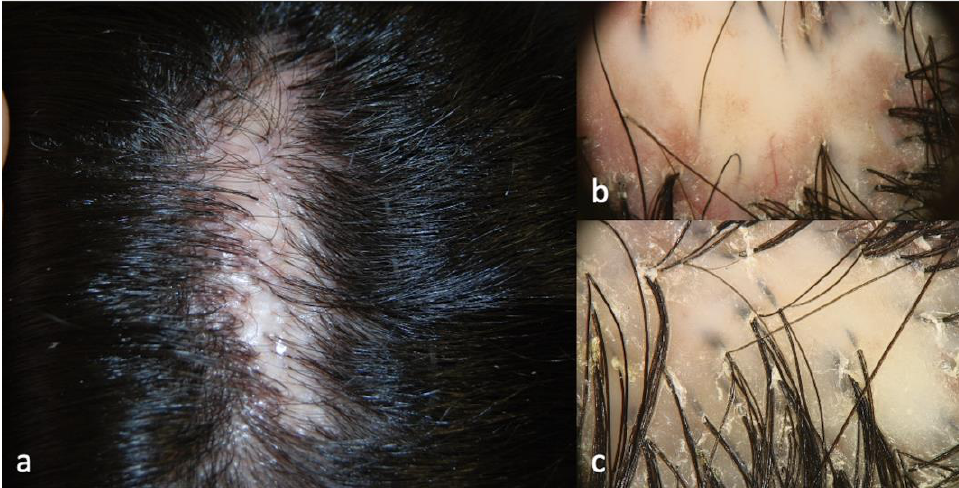
Figure 2. Histological findings of Patient 1. ( a ) Parakeratosis, focal absence of granular layer, neu- trophilic infiltrate in the papillary dermis and mantles (sebaceous structures), H&E 10× magnifica- tion; ( b ) dilated vessels in the dermis and neutrophilic infiltrate, H&E 10× magnification; and ( c ) high magnification of mantles (sebaceous structures), H&E 40× magnification.